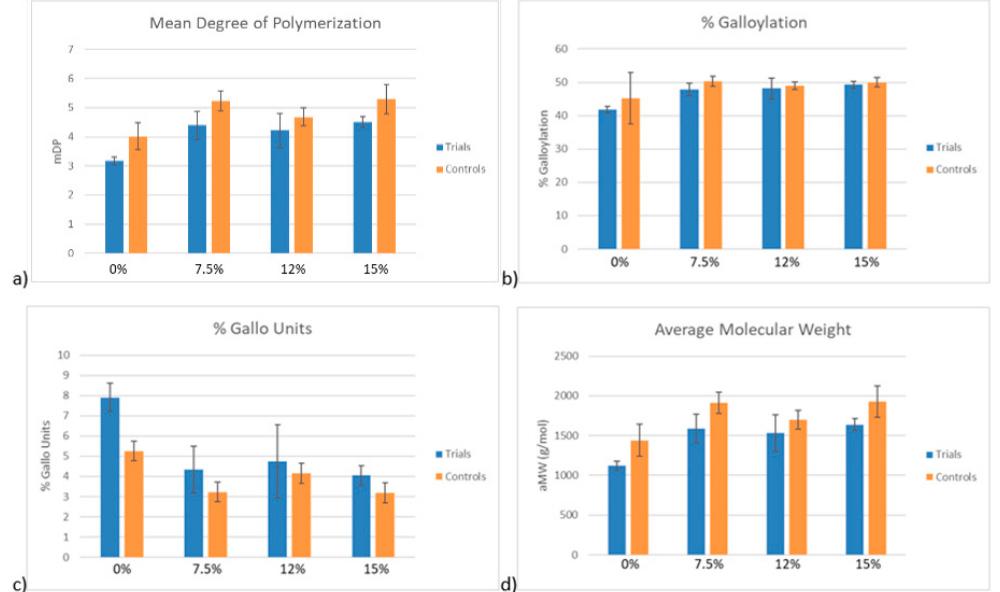
Figure 4. The results of phloroglucinolysis comparing PA composition in solution of trial and control samples at the end of the desorption experiment (samples taken at 35 ◦ C). mDP—mean degree of polymerization; aMW—average molecular weight.